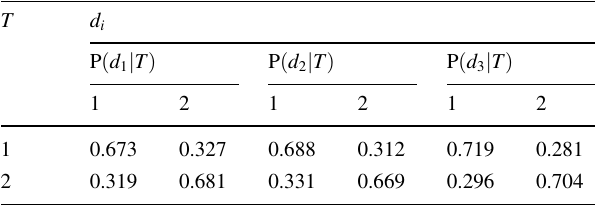
Table 11 Conditional probability table of each Bayesian network node